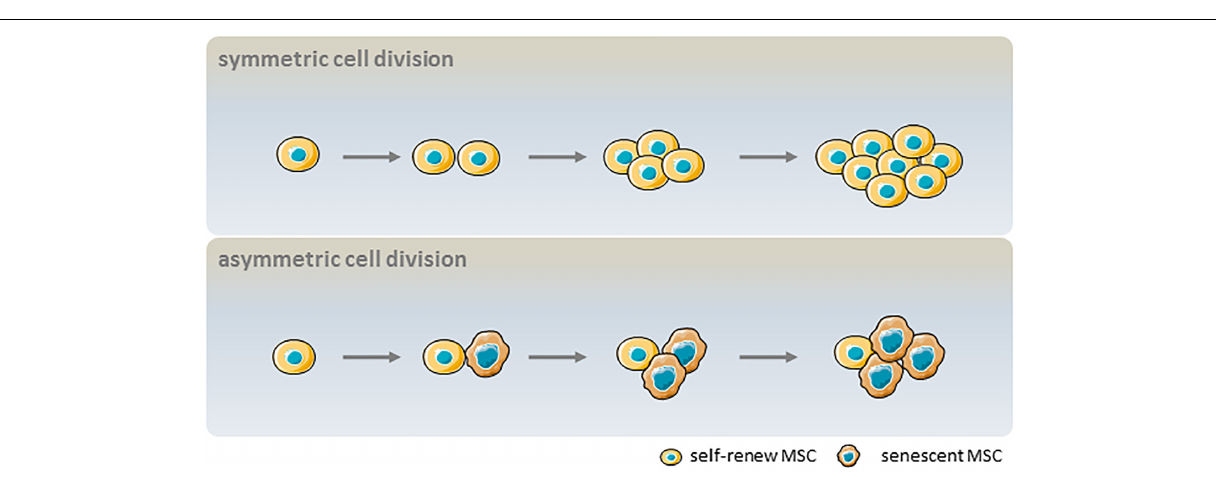
FIGURE 3 | Influence of asymmetric cell division kinetics on the heterogeneity of MSC senescence. In symmetric cell division, a parent MSC with self-renewal capacity divides into two daughter MSCs that can also self-renew. In asymmetric cell division, a parent MSC with self-renewal capacity divides into one self-renewing and one non-dividing cell that becomes senescent in